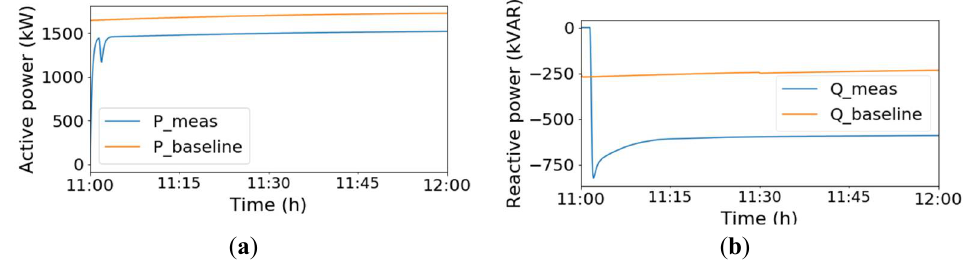
Figure 16. Total PV measurements: ( a ) active power output in baseline mode (P_baseline) and active power output with DERMS control (P_meas) and ( b ) reactive power output in baseline mode (Q_baseline) and reactive power output with DERMS control (Q_meas).